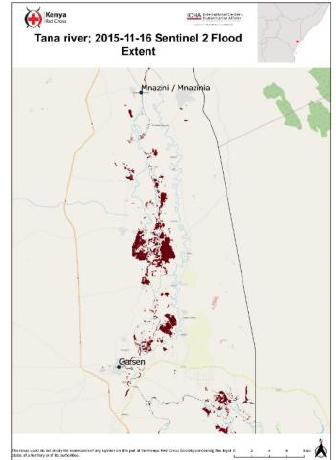
Figure 6 2015-11-16 Sentinel 2 flood